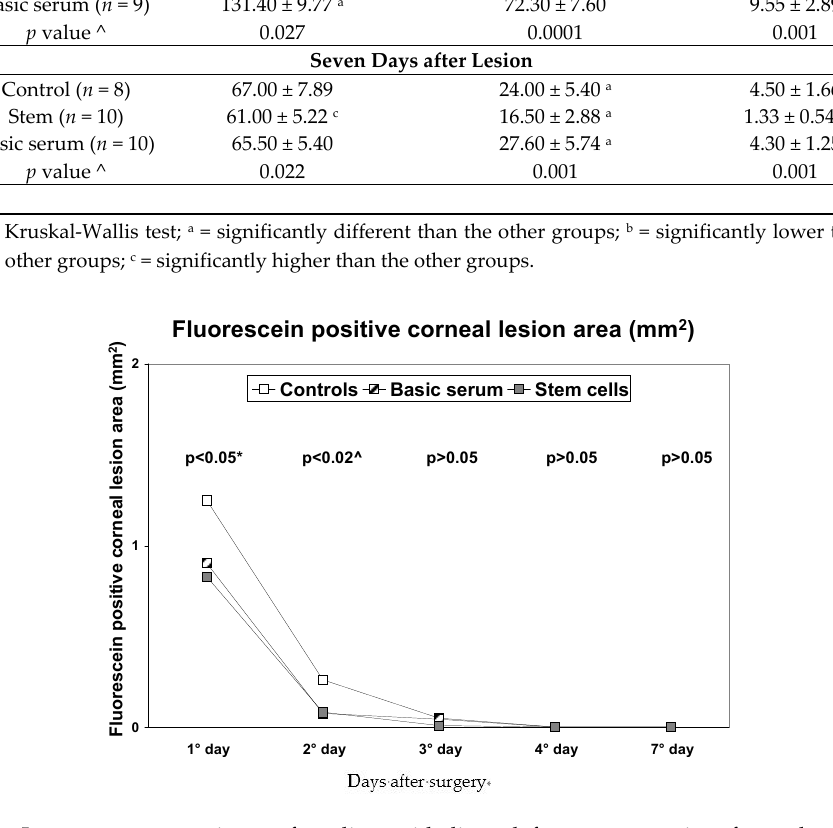
Figure 1. Intragroup comparisons of median epithelium defect area over time for each treatment group in the mice eyes. * = statistically significant difference between stem cells and control groups; ^ = statistically significant difference between controls and the other groups.